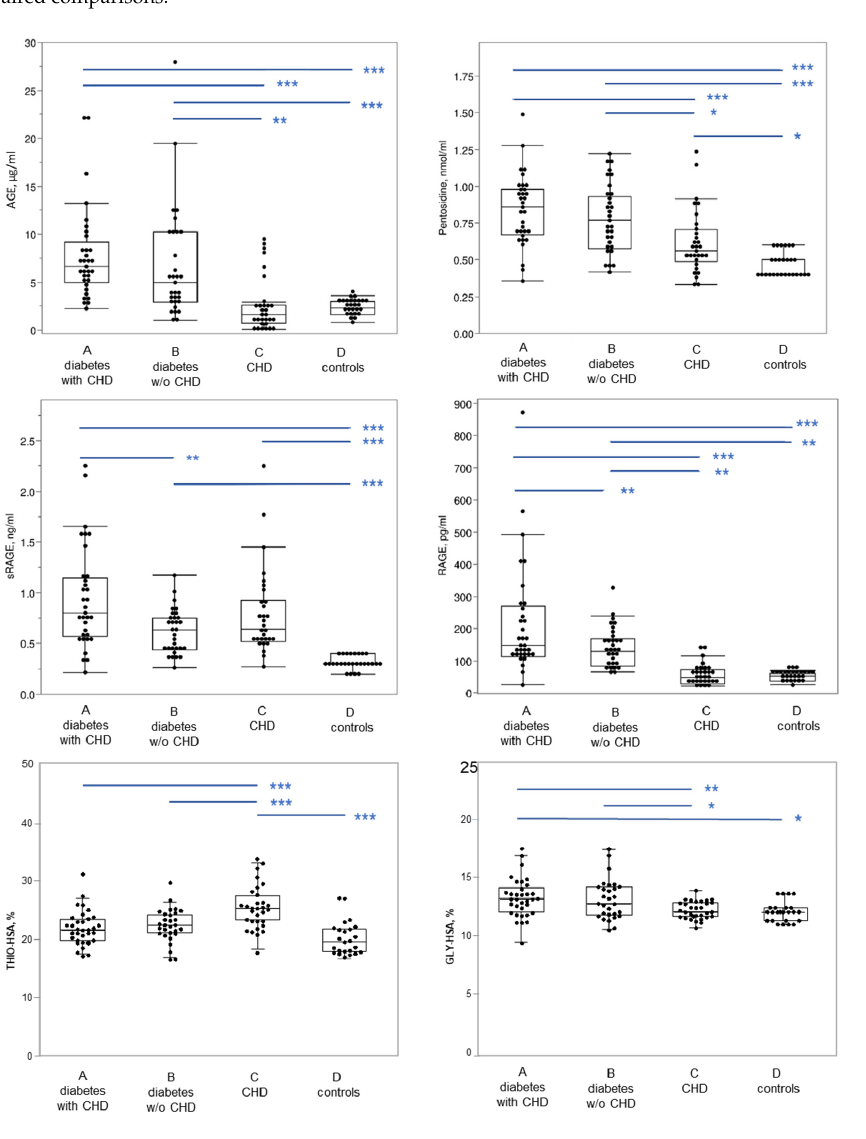
Figure 2. Glycation and oxidation parameters evaluated in the four groups of subjects. In the box plot, the ends of the box represent the 1st and 3rd quartile, respectively. Each box is divided by a line, which represents the median value. The whiskers show the values corresponding to [1st quar- tile − 1.5 × (interquartile range)], and [3rd quartile + 1.5 × (interquartile range)]. Horizontal blue lines on the top part of the graph indicate post hoc comparisons between groups by Tukey’s HSD test, following significant ANOVA. AGE, advanced glycation end products; GLY-HSA, glycated albu- min; RAGE, receptor for advanced glycation end-products; sRAGE, soluble RAGE; THIO-HSA, thi- olated albumin; CHD, coronary heart disease *** p < 0.001; ** p < 0.01; * p < 0.05. When considering all the patients, positive significant correlations were found be- tween AGE and FPG, HbA1c, RAGE ( r 0.29 , p = 0.004; r 0.28 , p = 0.007; r 0.38 , p = 0.0002; respectively), but not for sRAGE. A positive correlation was also found between RAGE and sRAGE ( r 0.59 , p < 0.0001), and between GLY-HSA and FPG and HbA1c ( r 0.37, p = 0.0002; and r 0.49, p < 0.0001, respectively) (Figure 3). Furthermore, significant negative